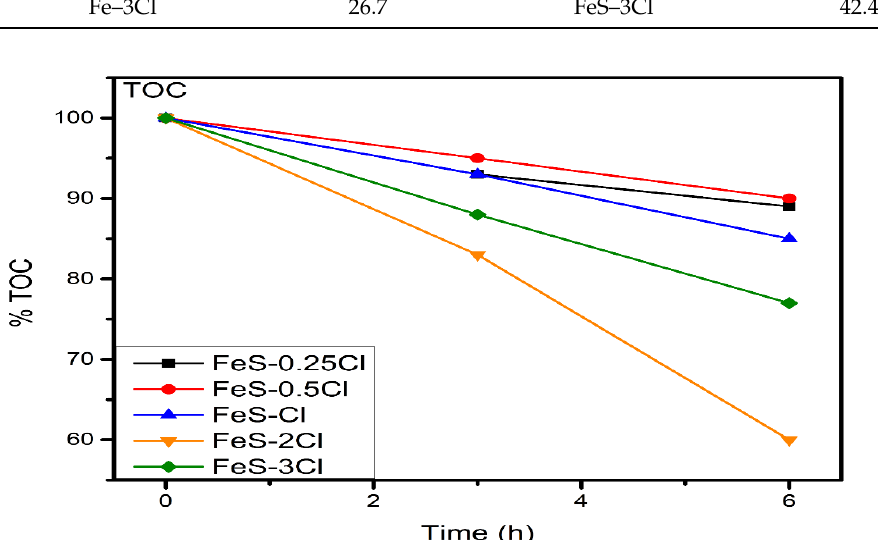
Figure 14. TOC results for FeS–0.25Cl, FeS–0.5Cl, FeS–2Cl and FeS–3Cl catalysts in visible-light region.